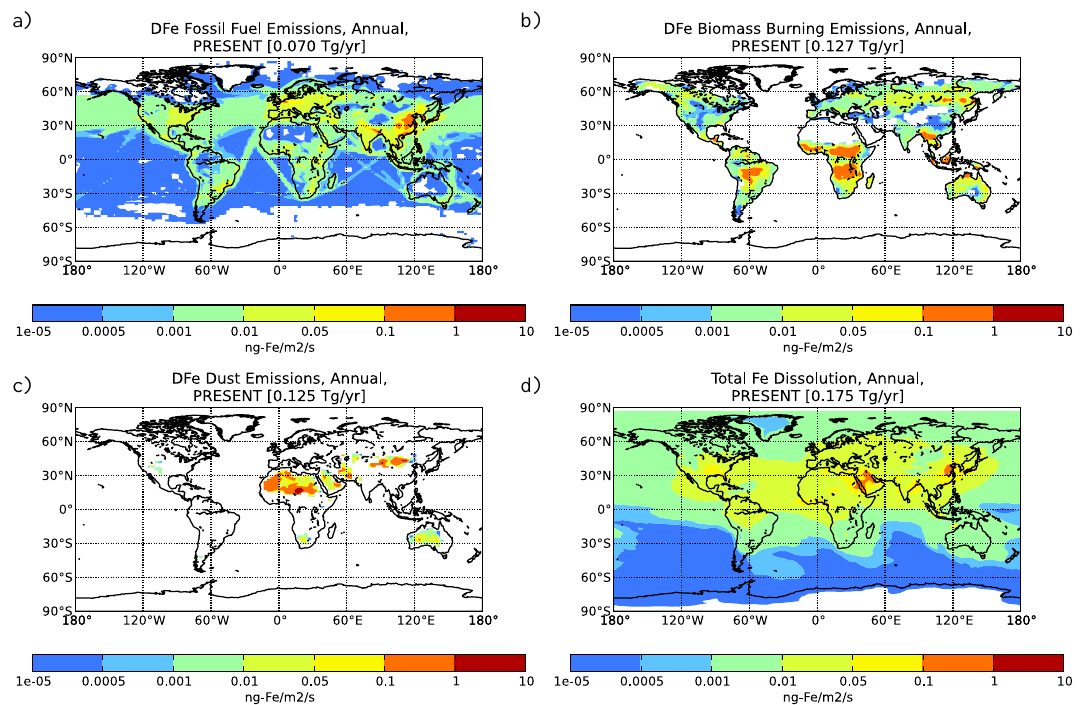
Figure 2. Annual averaged distributions (in ng-Fem − 2 s − 1 ) of (a) total anthropogenic DFe primary emissions, (b) total biomass-burning DFe emissions, (c) total DFe mineral emissions and (d) total mineral-Fe dissolution flux as calculated by TM4-ECPL for the present